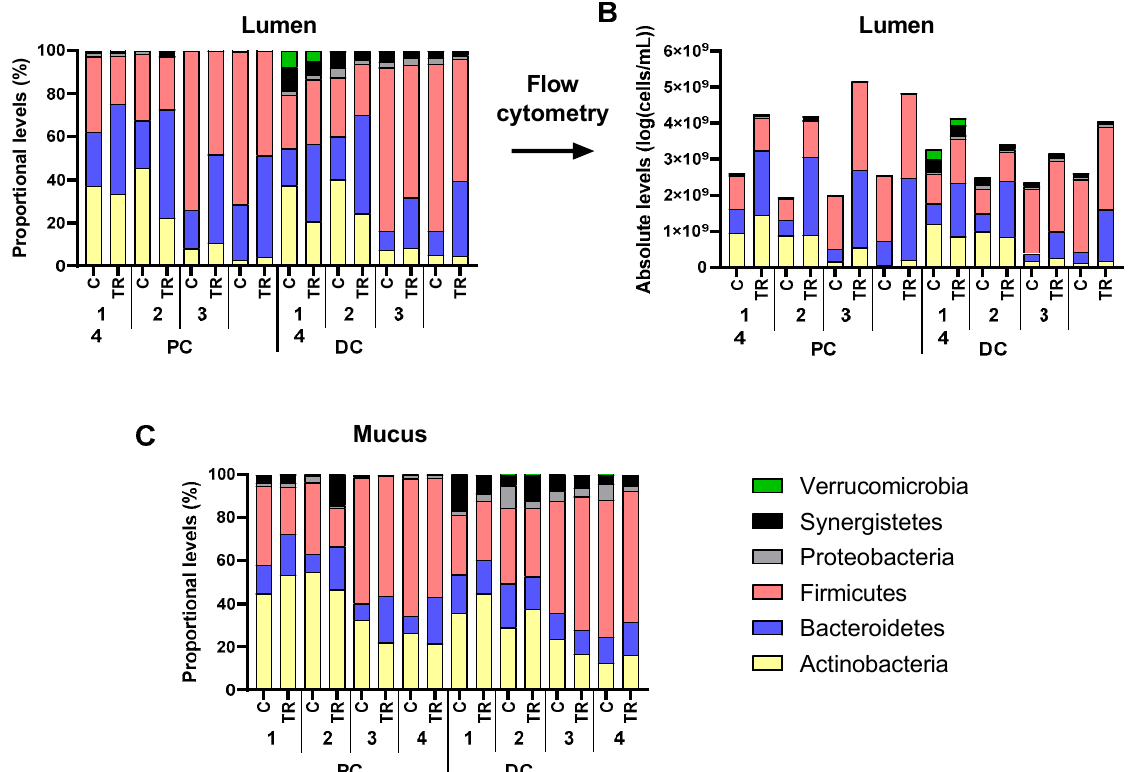
Figure 5. Effect of cRG-I on microbial composition (phylum level) in the lumen (log cells/mL as estimated via multiplying total cell counts (cells/mL) with 16S rRNA gene profiling (%)) ( A , B ) and mucus (%) ( C ) of the simulated proximal and distal colon of the quad-M-SHIME at the end of the control (C: Day 14) and treatment period (TR: Day 35). Average absolute (cells/mL as estimated via multiplying total cell counts (cells/mL) with 16S rRNA gene profiling (%)) ( A ) and proportional (%) ( B , C ) levels of different phyla are shown for each of the four human adult donors tested ( n = 3 for donor 1, 2, 3, and 4; samples collected during the last control and treatment week). cRG-I = carrot-derived Rhamnogalacturonan I, DC = distal colon, PC = proximal colon.